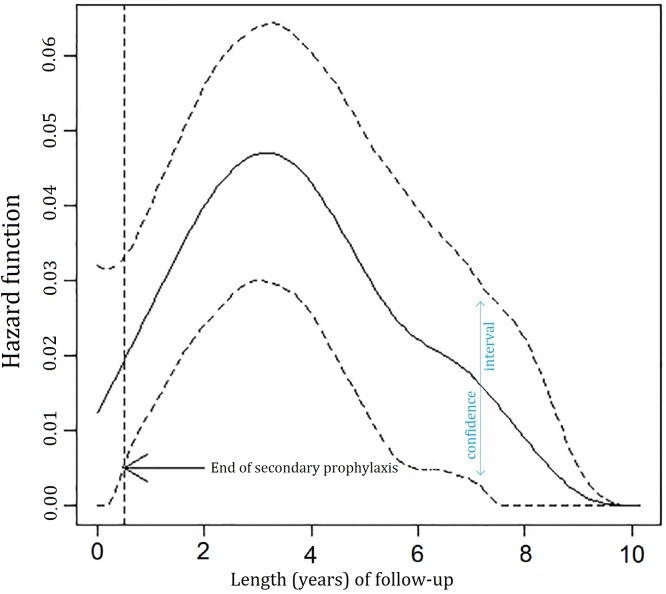
Hazard function (95% CI) derived from the final multivariate model.